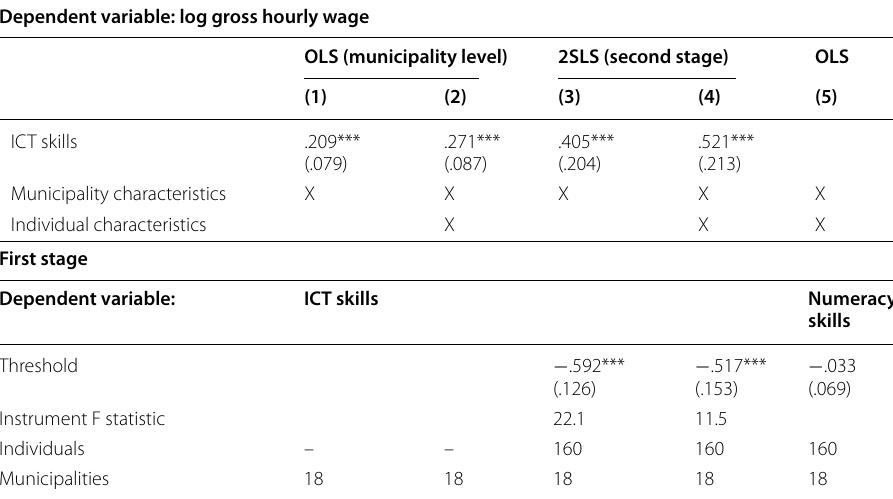
Table 5 Robustness of returns to ICT skills in sample of municipalities without own main distribution frames. Source: adapted from Falck et al.